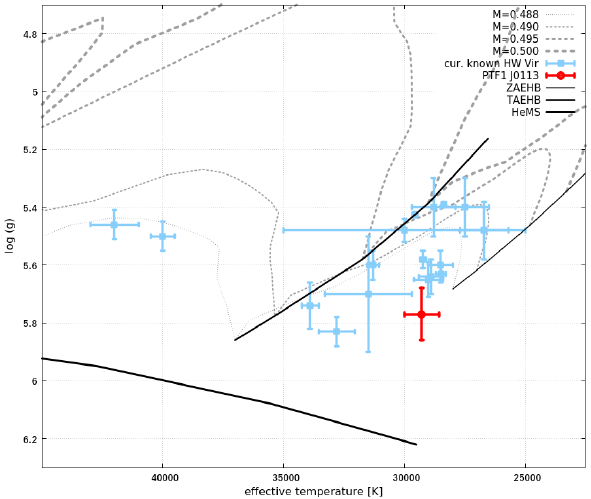
Figure 4. Position of PTF1 J0113 in a T eff − log( g )-diagram. For com- parison the other currently known HW Vir systems are shown. Dash dotted lines: Extreme horizontal branch (EHB) evolutionary models for various sdB masses (Dorman et al., 1993). In addition the zero- age extreme horizontal branch (ZAEHB) as well as the terminal age extreme horizontal branch (TAEHB) and the helium main sequence are shown.